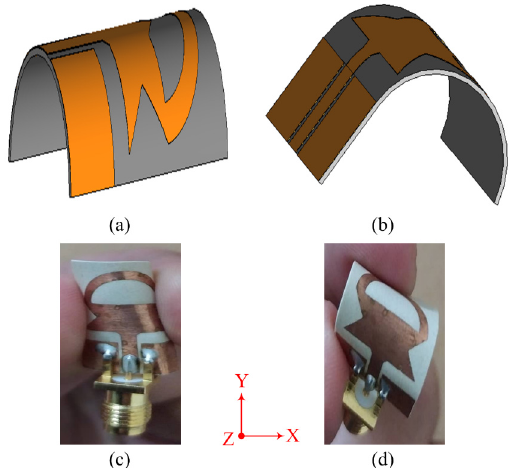
Figure 8. Simulation setup for conformal structure ( a ) X -axis ( b ) Y -axis ; fabricated prototype of the proposed antenna bent along ( c ) X -axis ( d ) Y -axis.